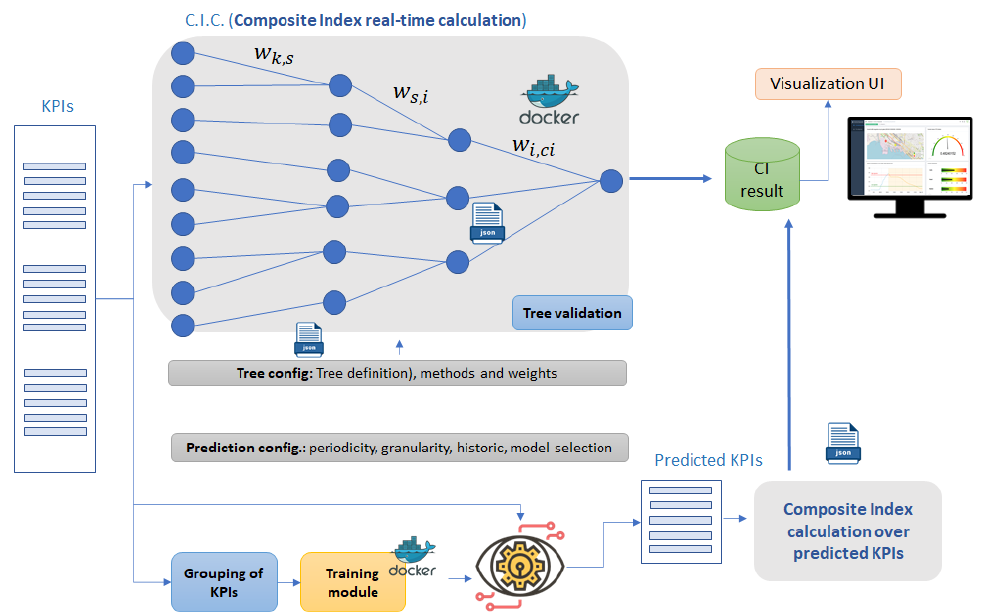
Figure 4. Composite Index calculation and prediction block.